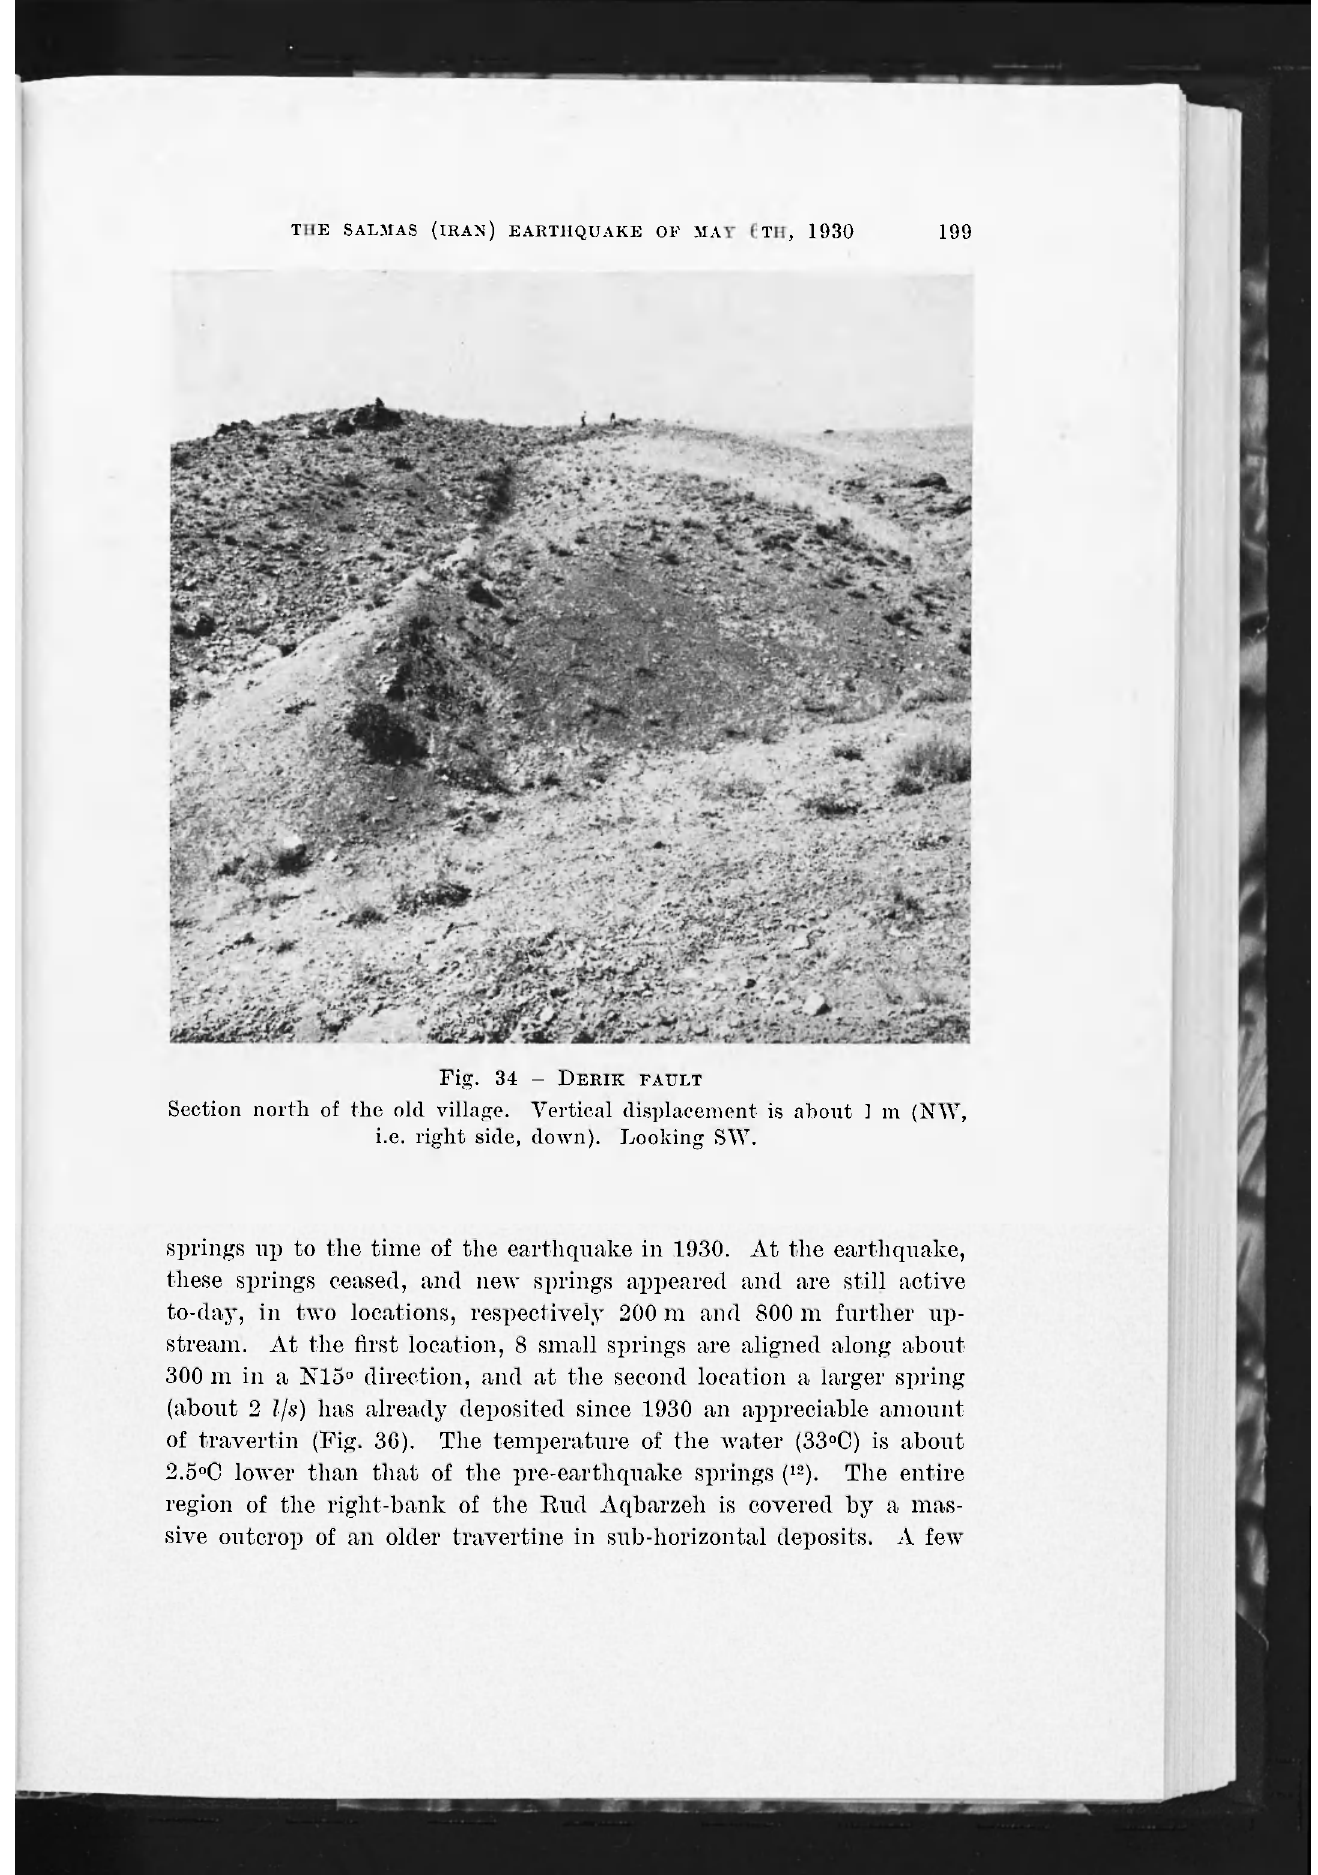
Fig. 34 - DERIK FAULT Section north of the old village. Vertical displacement is about 1 m (NW, i.e. right side, down). Looking